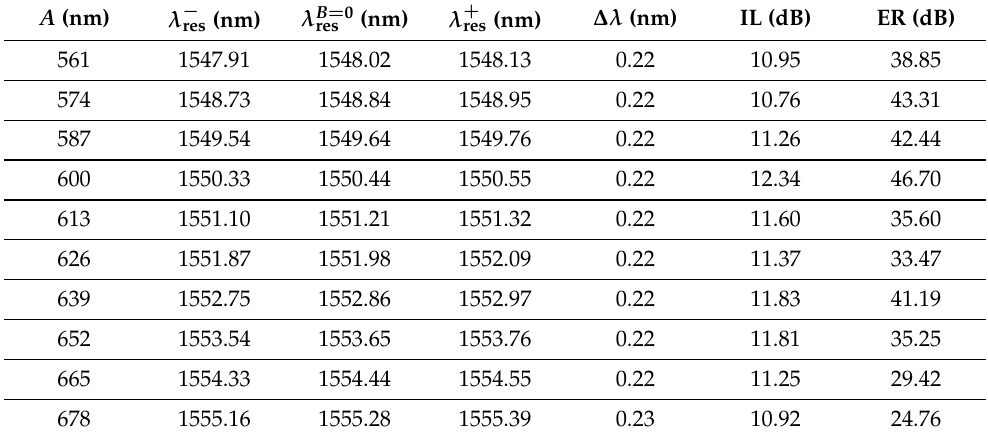
Table 2. Length A for each optical channel modulation spaced, for 100 GHz DWDM